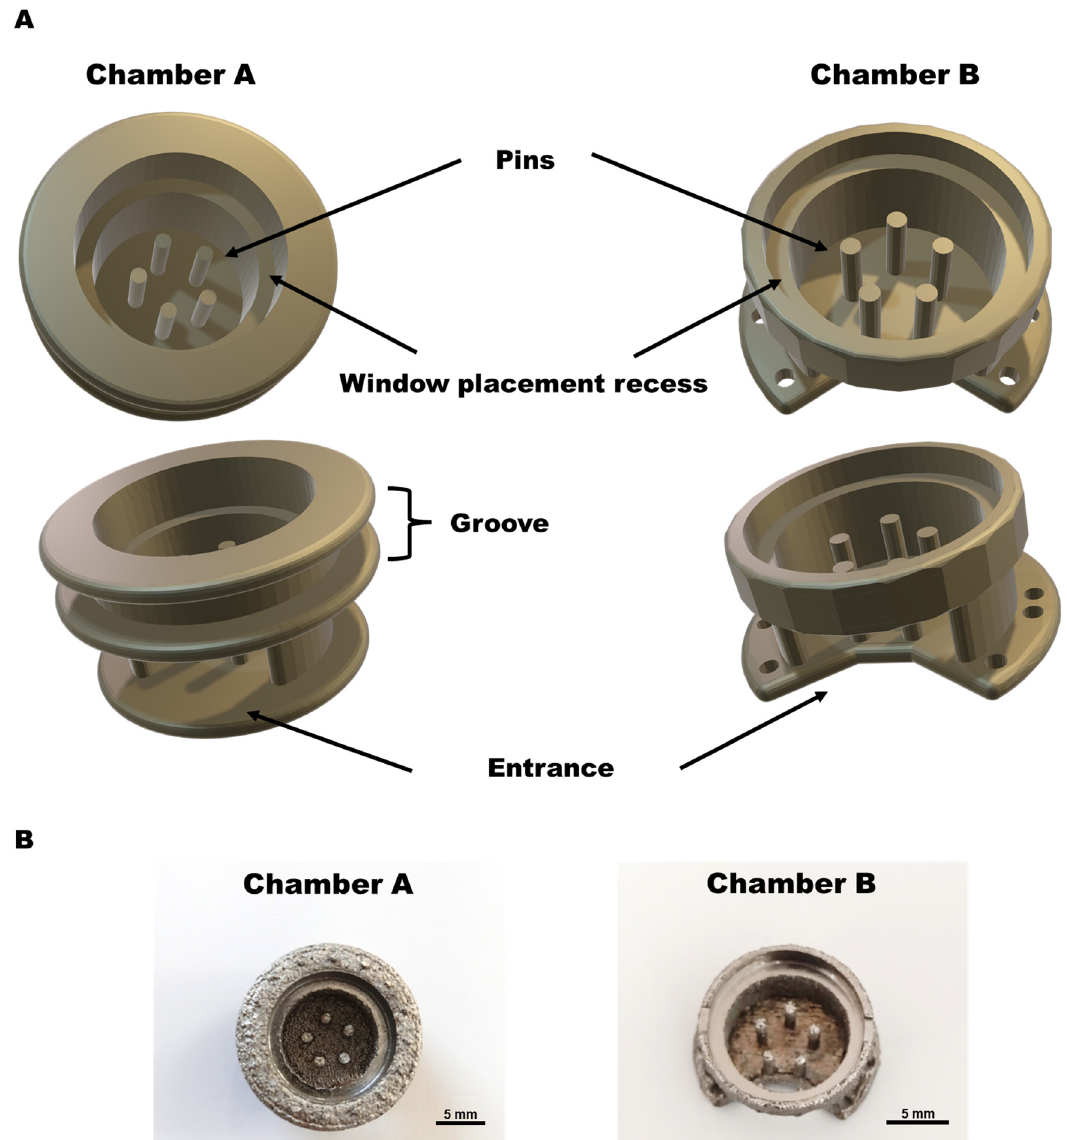
Figure 1. Chamber designs. ( A ) A CAD illustration of chamber designs. ( B ) Chambers after CNC processing. Chambers are produced as single-piece designs containing a spherical base chamber with five pins in the middle for retaining the AV loop and a circular recess on the top part of the chamber to accommodate the circular glass window. Chamber A contains an additional groove for fixing the chamber to the skin. Scale bar: 5 mm. Additional 3D design sketches in Supplementary